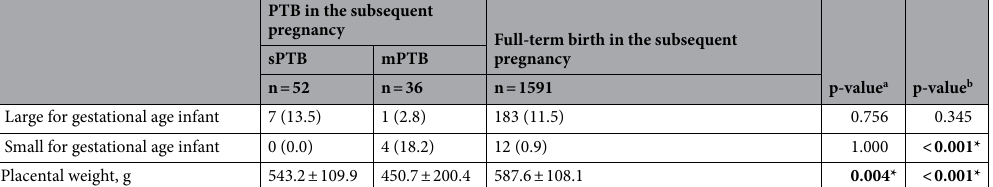
Table 1. Baseline characteristics and perinatal outcomes. PTB, preterm birth; sPTB, spontaneous PTB; mPTB, medically indicated PTB; GDM, gestational diabetes mellitus; BMI, body mass index; DM, diabetes mellitus; ART, assisted reproductive technology; GA, gestational age; HDP, hypertensive disorders of pregnancy; PE, preeclampsia. Data are presented as means ± standard deviation for continuous variables and n (%) for discrete variables. *Statistically significant. Significant values are in bold. a p-value for compareing full-term birth group and sPTB; b p-value for compareing full-term birth group and mPTB.